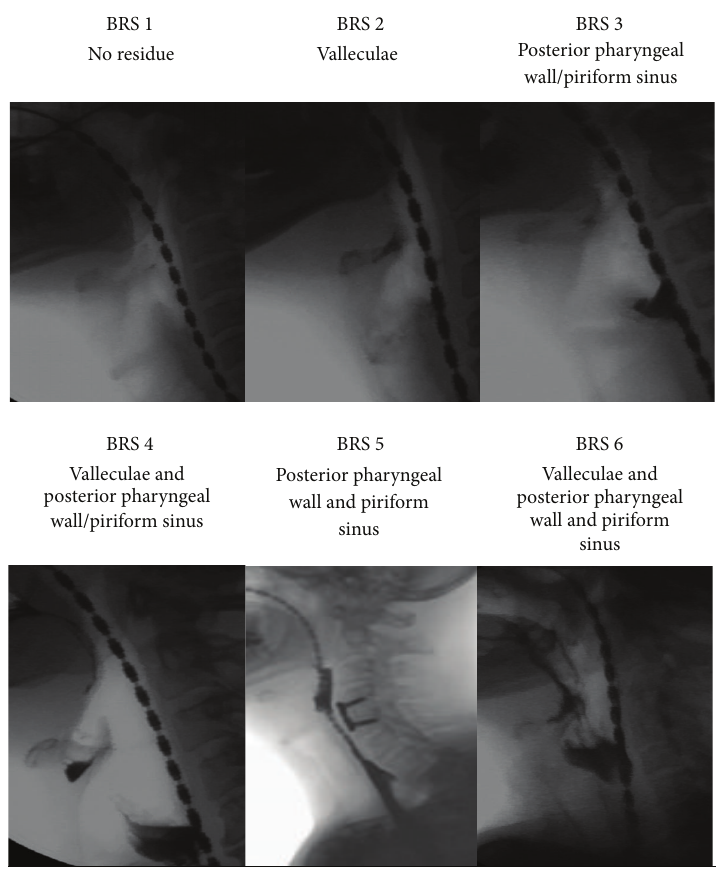
Figure 1: Videofluoroscopic image for each BRS score